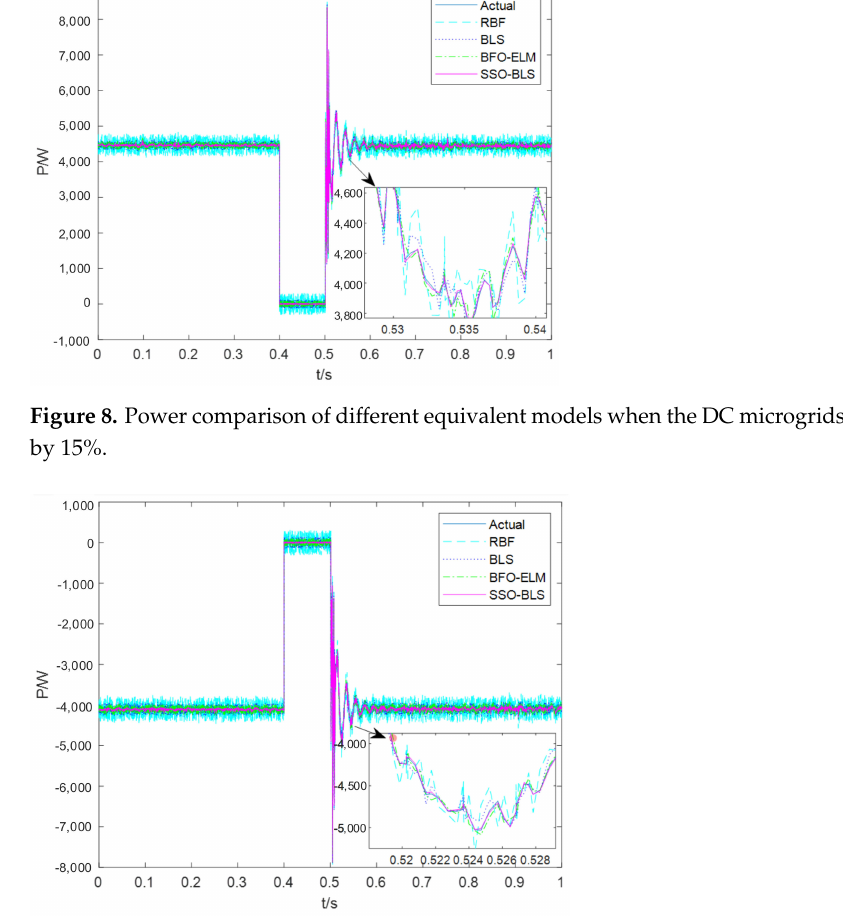
Figure 9. Power comparison of different equivalent models when the DC microgrids load is increased by 50%.